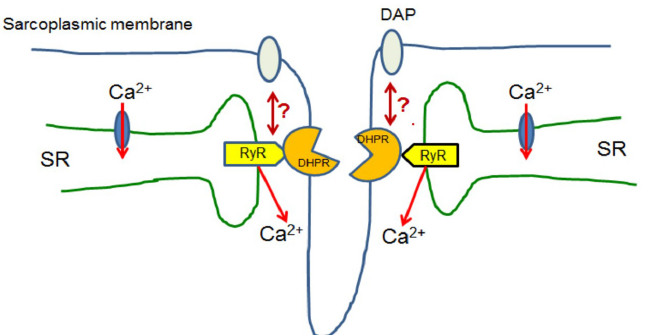
Figure 2. Skeletal muscle. Upon excitation, skeletal myofibres L-type calcium channel (DHPR/LTCC) proteins localised in selected regions of the sarcoplasmic membrane interact with ryanodine receptors (RyR) localised in the specific regions of the sarcoplasmic reticulum (SR). Such structures are known as triads. Ca 2+ released by these RyRs activates muscle contraction and then is transported back to SR. Presumably, dystrophin associated complex indirectly interacts with this mechanism, but its role is still unclear [45].